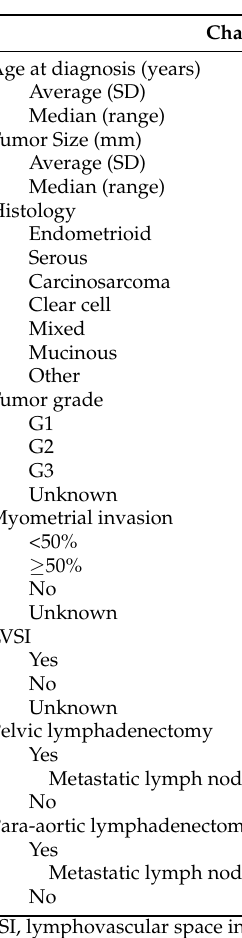
Table 1. General patient